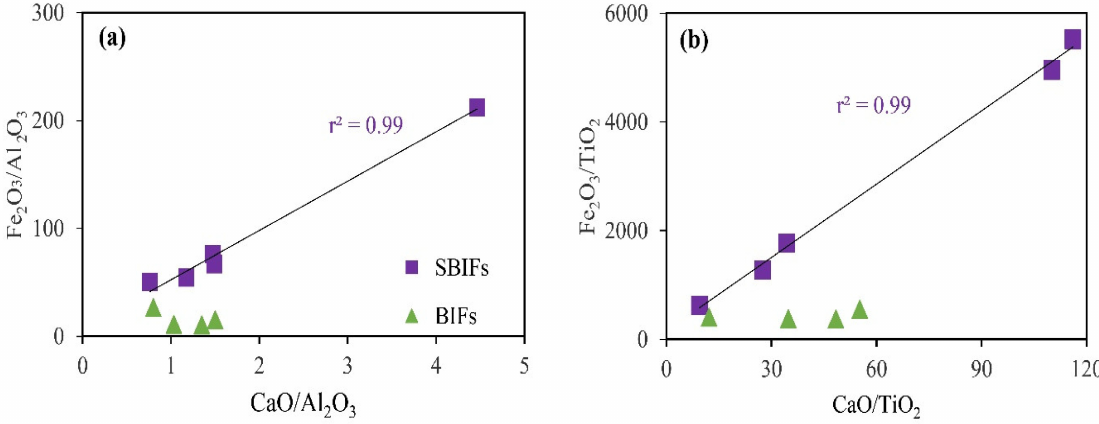
Figure 11. ( a ) Fe 2 O 3 /Al 2 O 3 vs. CaO/Al 2 O 3 and ( b ) Fe 2 O 3 /TiO 2 vs. CaO/TiO 2 binary plots [10]; hydrothermal alteration effect on the Anyouzok IFs.